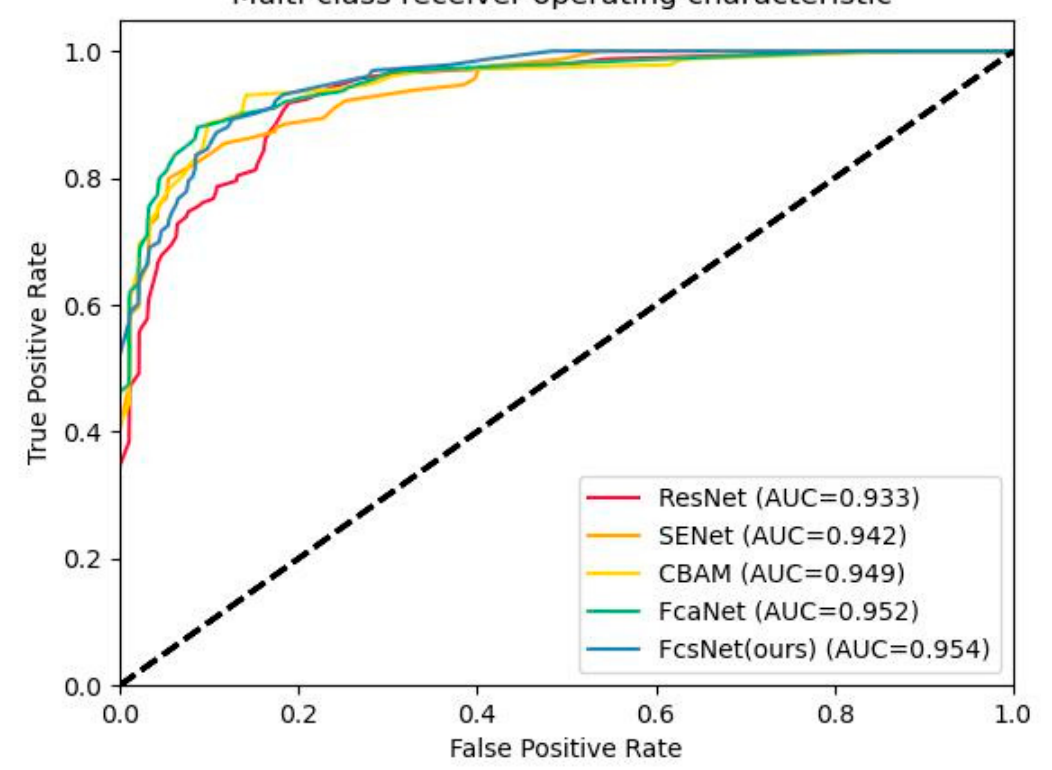
Figure 8. ROC comparison of different models. The horizontal axis is the false positive rate, the vertical axis is the true positive rate, and the lower right corner is the color and AUC value corresponding to the model.